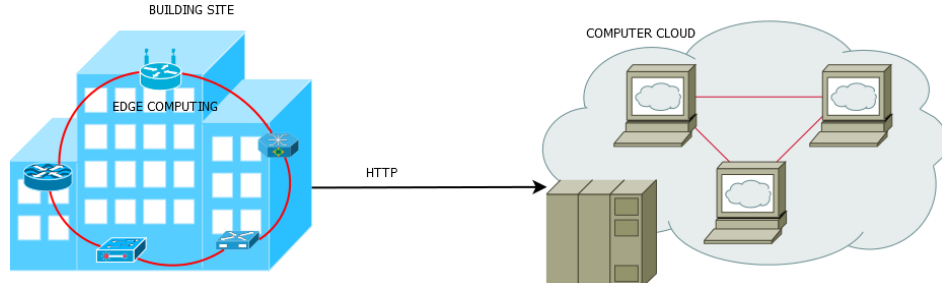
Figure 1. Building site and cloud infrastructure for